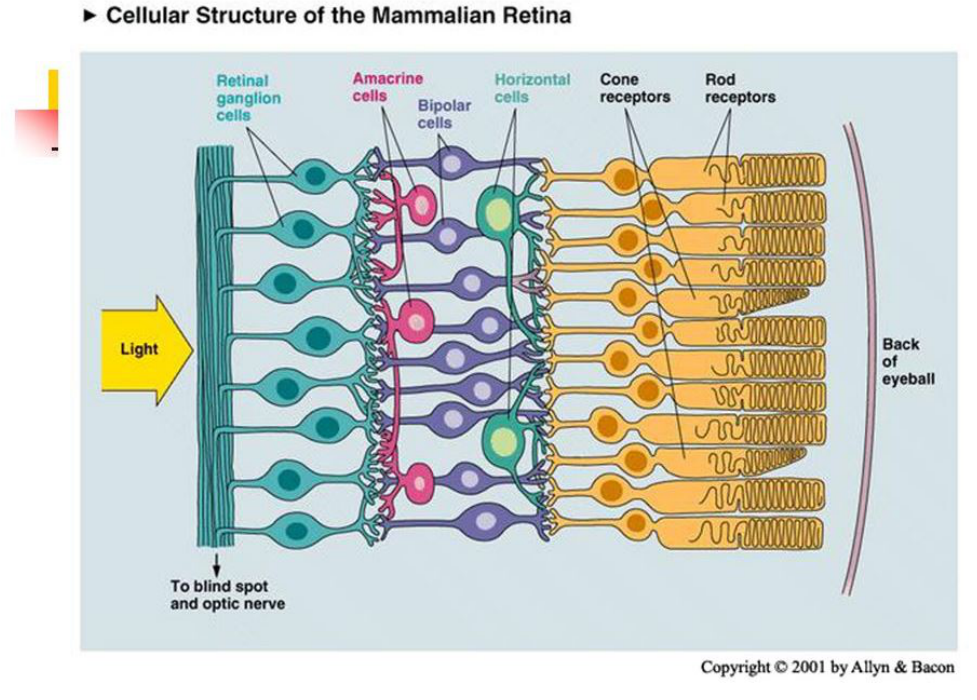
Figure 3. Anatomy of